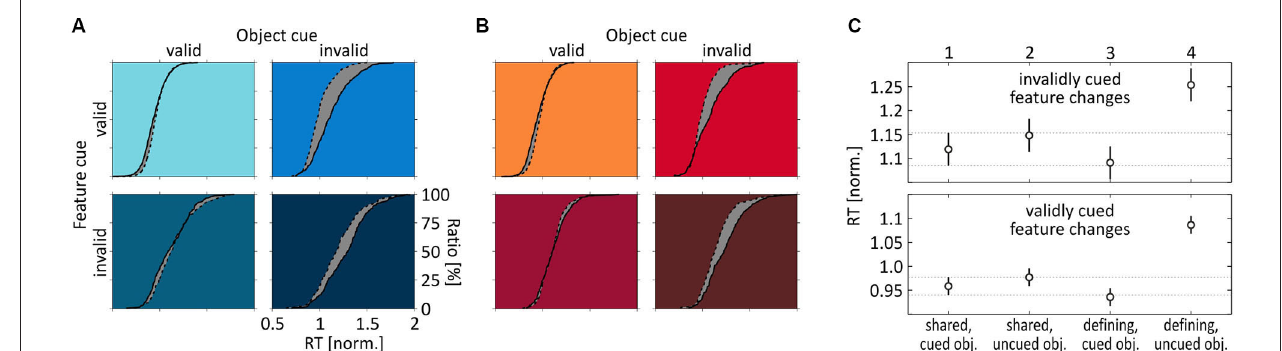
invalidly (top) and validly (bottom) cued features. RTs are pooled across both speed and color-change trials. Error bars indicate 95% confidence intervals for each mean, and the horizontal lines plot the 95% CI estimated for changes of the shared feature at the cued object, as a reference. Numbers on top of upper x-axis indicate stimulus and cue condition for reference to statistical comparisons summarized in Table 2 .